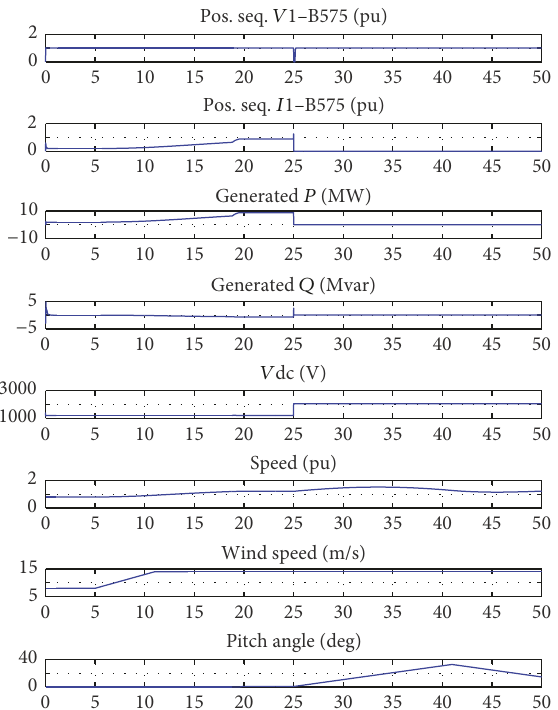
Figure 16: Simulation results for fault condition with a step change increase in wind speed from 8 m/s to 14m/s at 5-second mark followed by a 150 ms duration three phases to ground fault at 25- second